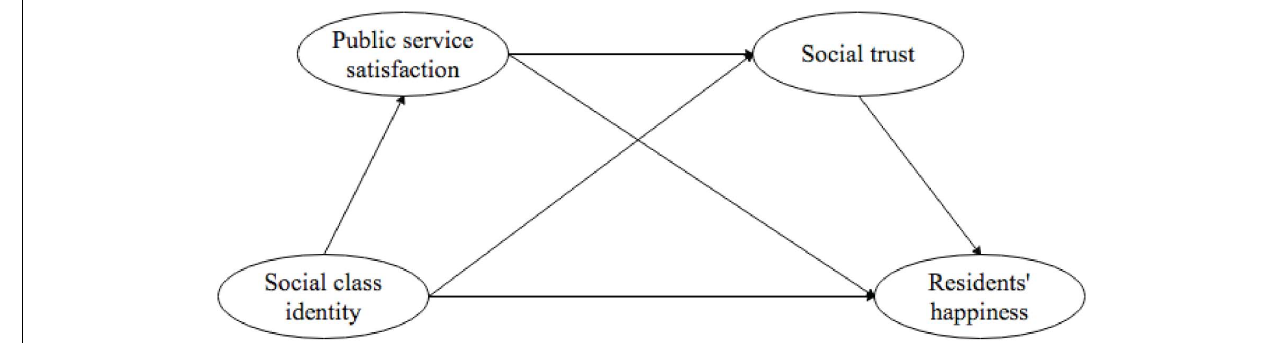
FIGURE 1 | Research model.